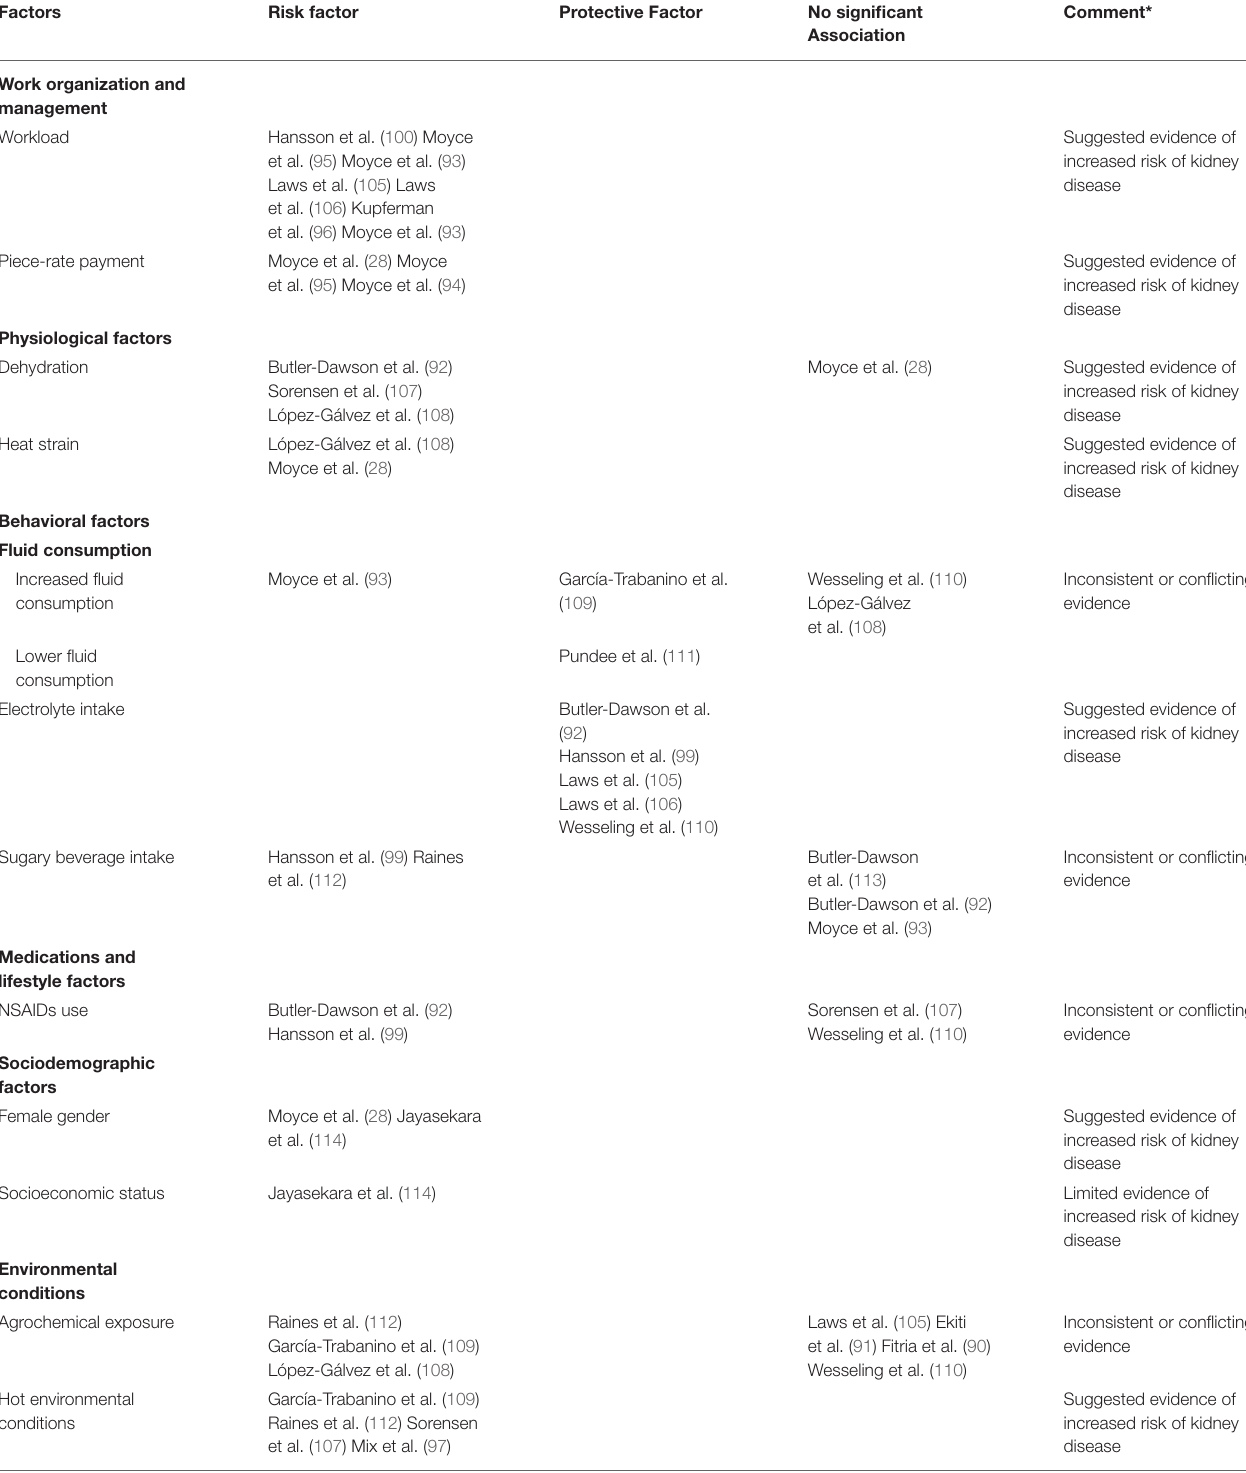
TABLE 4 | Risk and protective factors associated with kidney